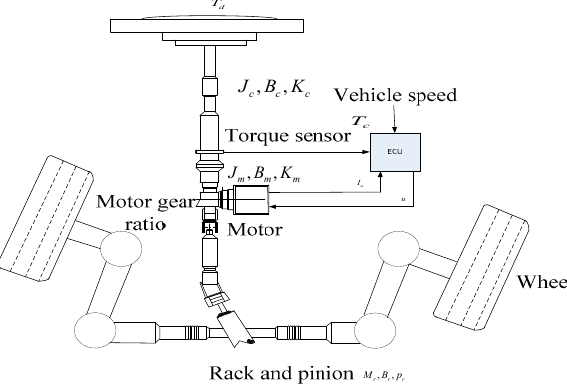
Figure 1. Electric power steering system model.